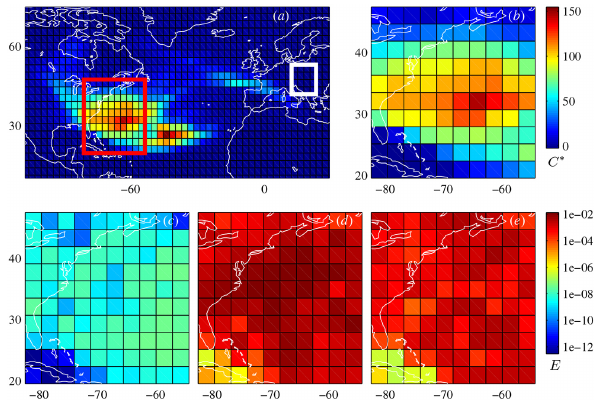
Figure 1. Comparison of sensitivities C ∗ for test case I. (a) Sen- sitivity calculated from a single run of RETRO-TOM by Eulerian backtracking. The white rectangle indicates the location of the re- ceptor region and the red rectangle illustrates the location of the source patch used in subsequent subplots. (b) The same sensitivity calculated directly from a 10 × 10 patch of TOMCAT forward runs. Results are indistinguishable from those shown in (a) . (c) Relative error of the Eulerian backtracking results in (a) in comparison to the (true) direct sensitivity in (b) . (d) As for (c) but with Eulerian backtracking performed without reversing the order of the opera- tors. (e) As for (c) but with Eulerian backtracking performed by naive RETRO-TOM, that is without initializing the density field to agree with that in the forward problem. Note the logarithmic colour scale for the error